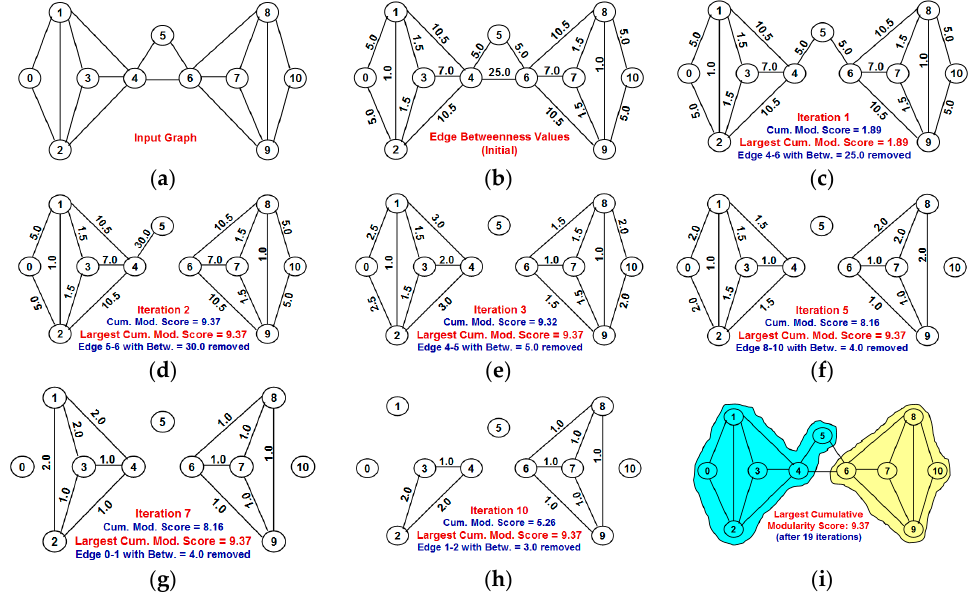
Figure 6. Example to illustrate the original Girvan-Newman algorithm for edge betweenness-based community detection (betweenness of the edges is updated for each iteration). ( a ) Input graph; ( b ) Betweenness values for the edges in the input graph; ( c ) At the end of Iteration 1: Remaining edges in the graph after edge 4–6 with Betweenness score of 25.0 is removed; ( d ) At the end of Iteration 2: Remaining edges in the graph after edges 5 and 6 with Betweenness score of 30.0 is removed; ( e ) At the end of Iteration 3: Remaining edges in the graph after edges 4 and 5 with Betweenness score of 5.0 is removed; ( f ) At the end of Iteration 5: Remaining edges in the graph after edge 8–10 with Betweenness score of 4.0 is removed; ( g ) At the end of Iteration 7: Remaining edges in the graph after edges 0 and 1 with Betweenness score of 4.0 is removed; ( h ) At the end of Iteration 10: Remaining edges in the graph after edges 1 and 2 with Betweenness score of 3.0 is removed; ( i ) At the end of Iteration 19: Final partitioning of the network graph into communities.